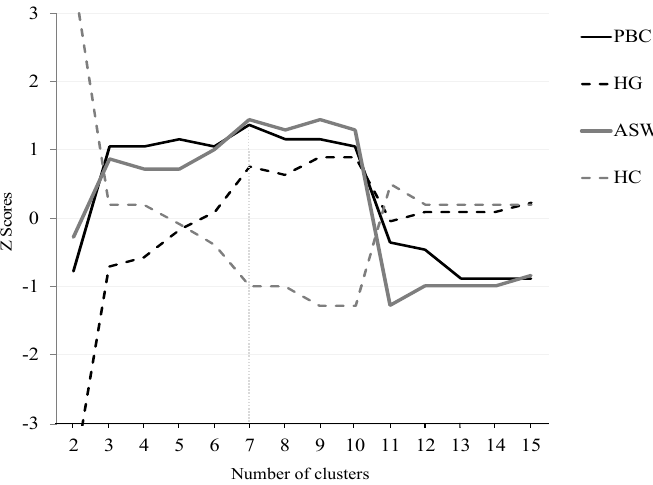
Figure 1. Cluster cut-off criteria. Note: All measures are standardized. PBC: Point Biseral Correlation. HG: Hubert’s Gamma. ASW: Average Silhouette width. HC: Hubert’s C coefficient.